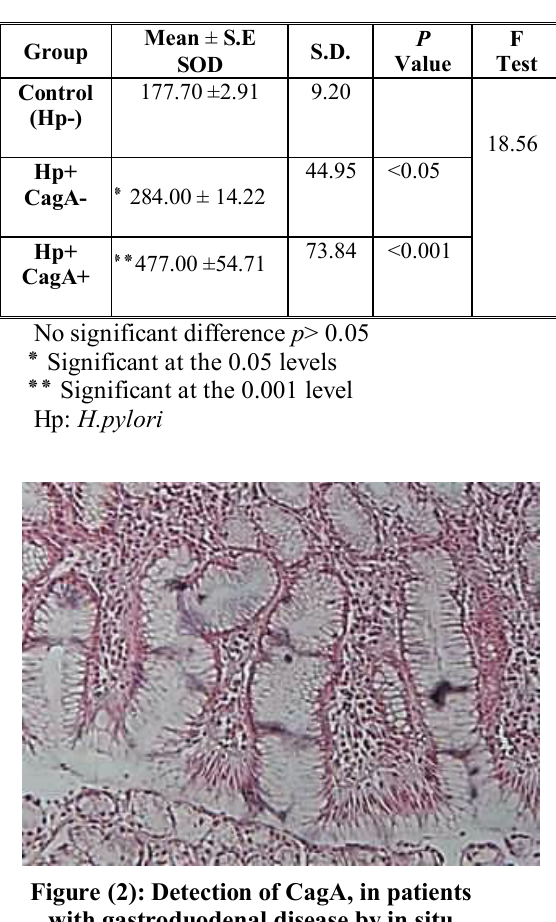
Figure (2): Detection of CagA, in patients with gastroduodenal disease by in situ hybridization . staining of CagA mRNA by BCIP/NBT (blue-black) counterstained with nuclear fast red. Tissue from patients with antral gastritis shows positive CagA by hybridization signals.